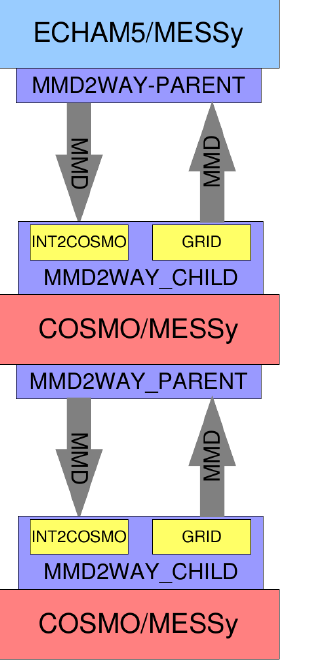
Figure 1. Illustration of the connection between the different MMD parts. The example is for a MECO(2) setup, i.e. EMAC with a cas- cade of two nested COSMO/MESSy instances.